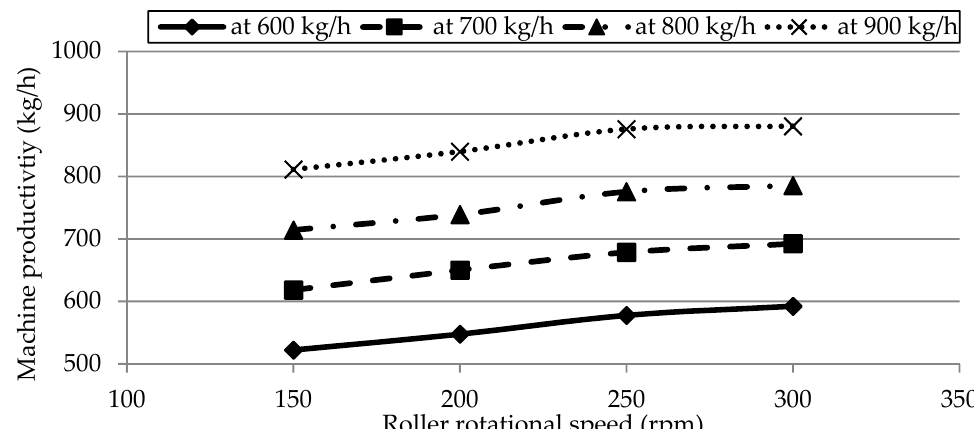
Figure 7. Effect of the roller’s rotational speed (rpm) on the machine’s productivity (kg/h) at different feed rates (kg/h).